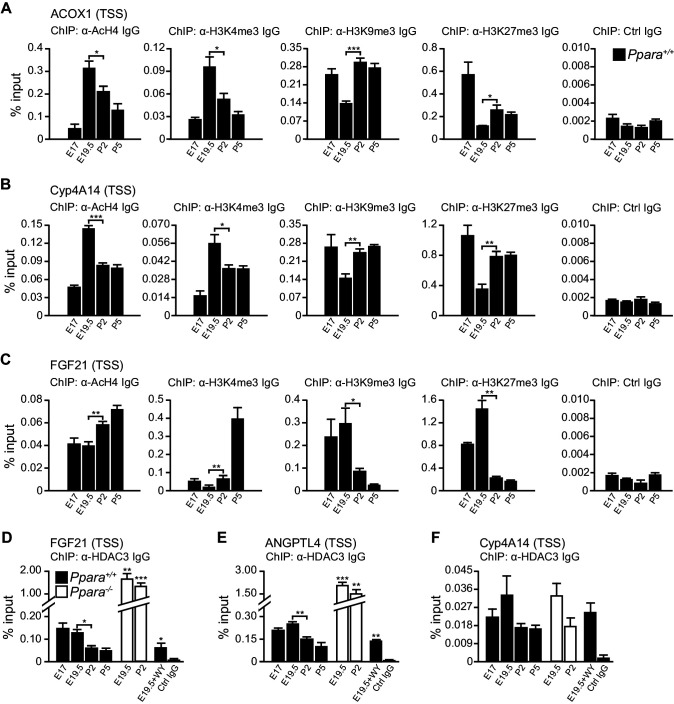
PPARα-mediated regulation of Fgf21 expression is dictated by the occupancy of HDAC3 on its promoter.(A–C) Enrichment of the DNA fragment containing the ACOX1 (A), Cyp4A14 (B), or FGF21 (C) TSS in primary hepatocytes isolated from Ppara+/+ pups using antibodies against acetyl-histone four (AcH4), trimethylated histone three at lysine four (H3K4me3), lysine nine (H3K9me3), lysine 27 (H3K27me3), or pre-immune IgG (Ctrl IgG) and evaluated by real-time qPCR. (D–F) Enrichment of the DNA fragment containing the FGF21 (D), ANGPTL4 (E), or Cyp4A14 (F) TSS in primary hepatocytes isolated from Ppara-/- and Ppara+/+ pups with or without WY-14643 treatment in pregnant dams using anti-HDAC3 antibodies or control IgG. Data are presented as mean ± SEM; n = 4–6, *p<0.05, **p<0.01, ***p<0.001 vs. untreated wild-type controls unless otherwise indicated (two-tailed Mann-Whitney test).